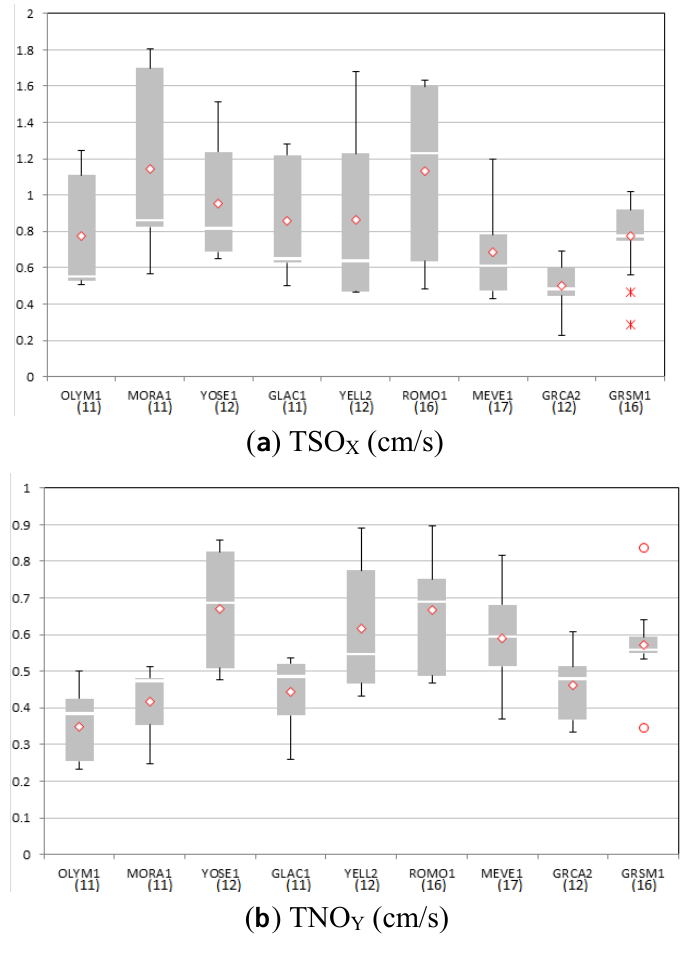
Figure 9. Box and whisker plots for variability in ( a ) TSO across all the model simulations at each IMPROVE site. The number in parentheses represents the number of each sample data. How to read a box and whisker plot is explained in the Figure 5